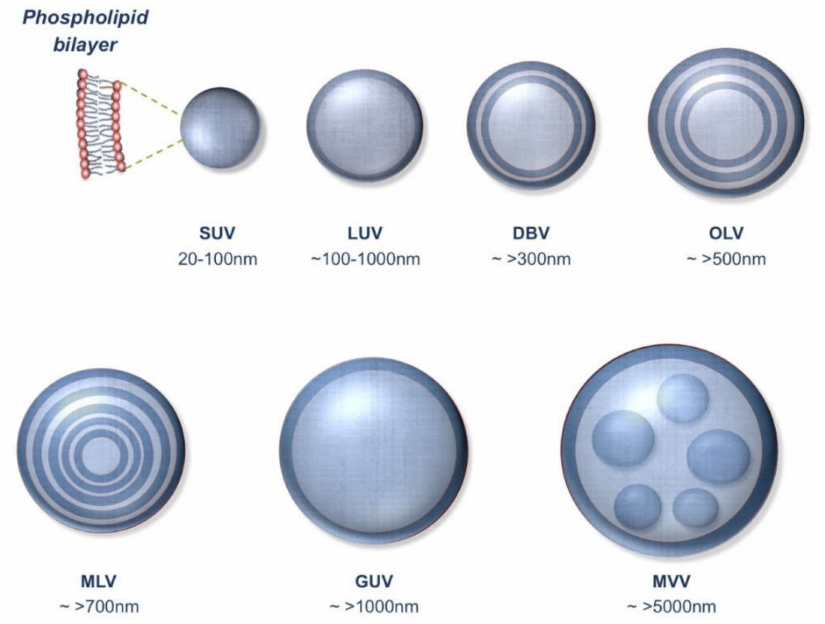
Figure 2. Different types of lipid vesicles. SUV: small unilamellar vesicle; LUV: large unilamellar vesicle; DBV: double bilayer vesicle; OLV: oligolamellar vesicle; MLV: multilamellar vesicle; GUV: giant unilamellar vesicle; MVV: multivesicular